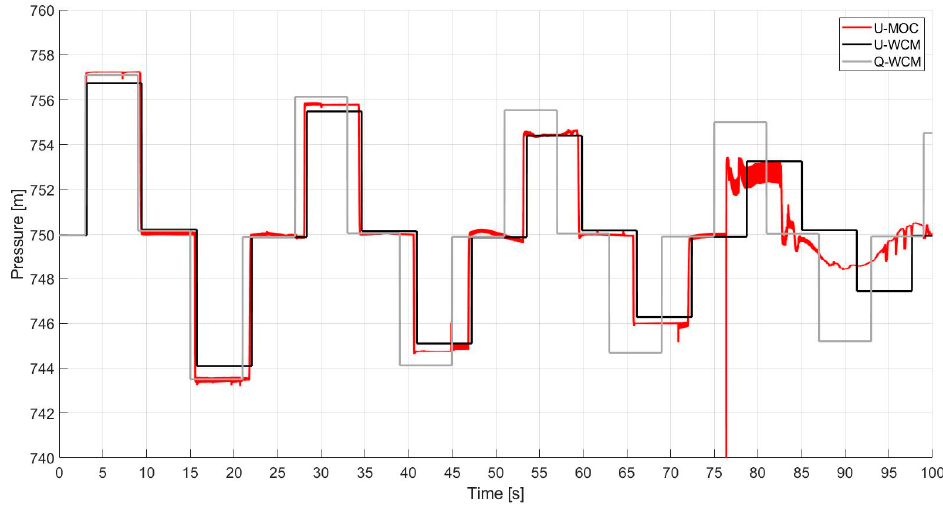
Figure 5. A comparison of the transient behavior at node 2 for the refined U-WCM (black) and the U-MOC (red) for the first case study—B variation. The quasi-model (Q-WCM) is illustrated in gray in the background.